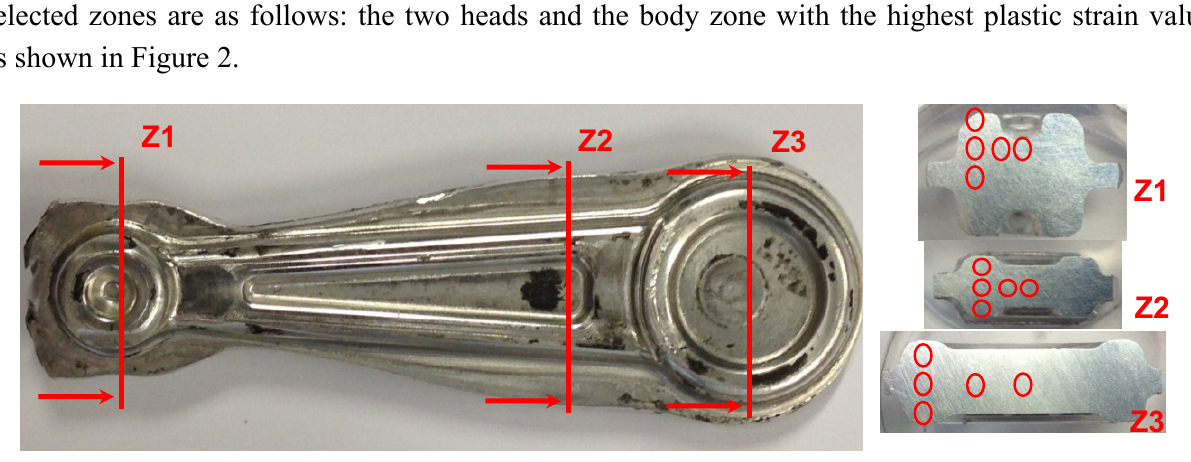
Figure 2. Selected study zones to be cut and points where Vickers microhardness (Hv) is